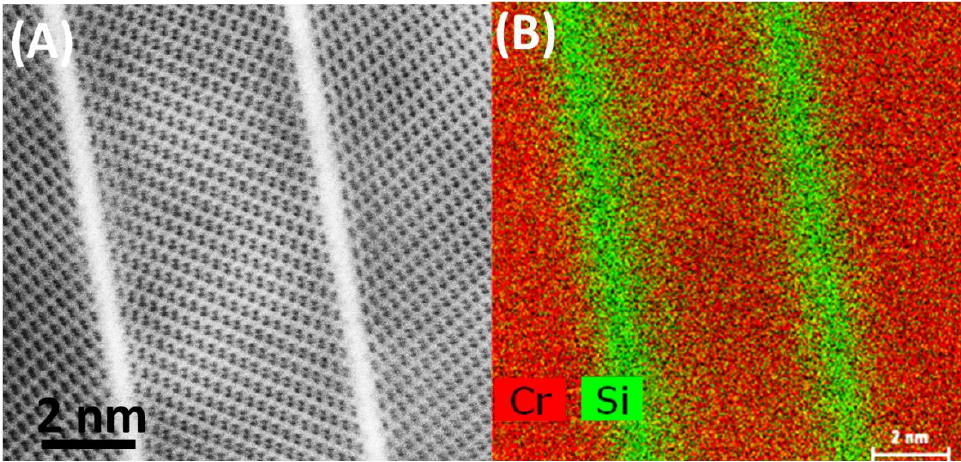
Figure 9. Cr 2 O 3 crystals: ( A ) STEM-BF image, ( B ) STEM-EDS map of Cr and Si .